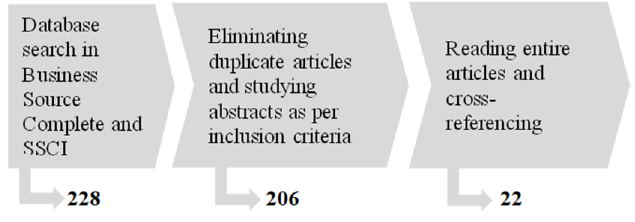
Figure 2. Article selection process.